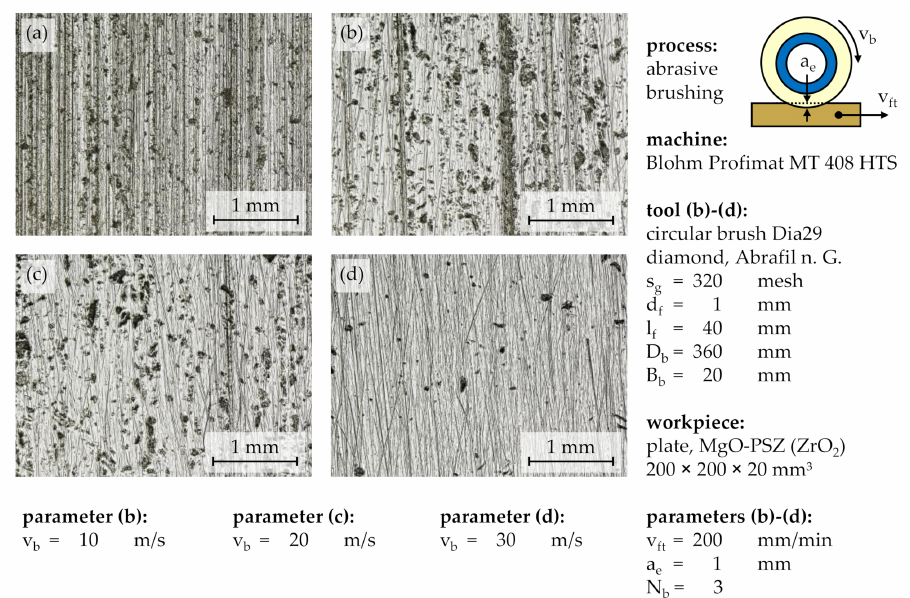
Figure 9. Light microscopy images of ZrO 2 under the variation of the brushing velocity v b : ( a ) ground surface; ( b ) brushed with a brushing velocity of v b = 10 m / s; ( c ) brushed with a brushing velocity of v b = 20 m / s; ( d ) brushed with a brushing velocity of v b = 30 m / s.